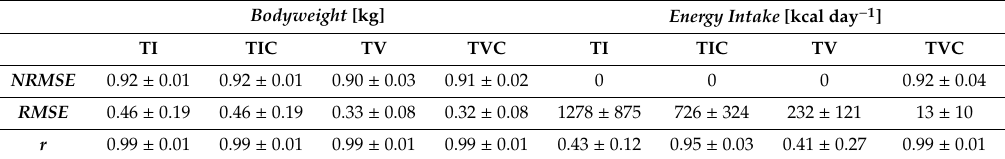
Table 6. Normalized root mean square error ( NRMSE ), root mean square error ( RMSE ) and Pearson correlation coe ffi cient ( r ) when comparing the MPC suggestions for energy intake and bodyweight outcome, with the energy intake and body weight from the Minnesota starvation experiment. The MPC systems tested are the one using the time-invariant parameters model without constraints (TI), the same one but with constraints (TIC), the MPC system using the time-variant parameter DARX model without constraints (TV) and this one with constraints (TVC). The RMSE for bodyweight has kg as units and the RMSE for energy intake has kcal day − 1 units. The NRMSE value is set to 0 when the energy intake suggested by the MPC and the measured energy intake curves follow diverging dynamics.